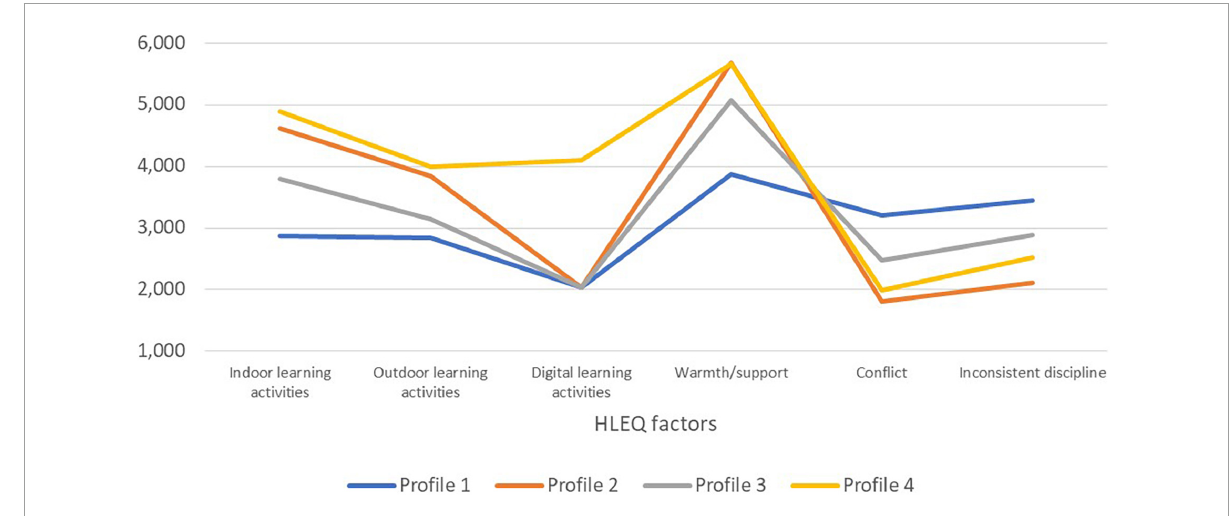
FIGURE2 Mean scores of home learning environment (HLE) profiles in each of the home learning environment questionnaire (HLEQ) factors.